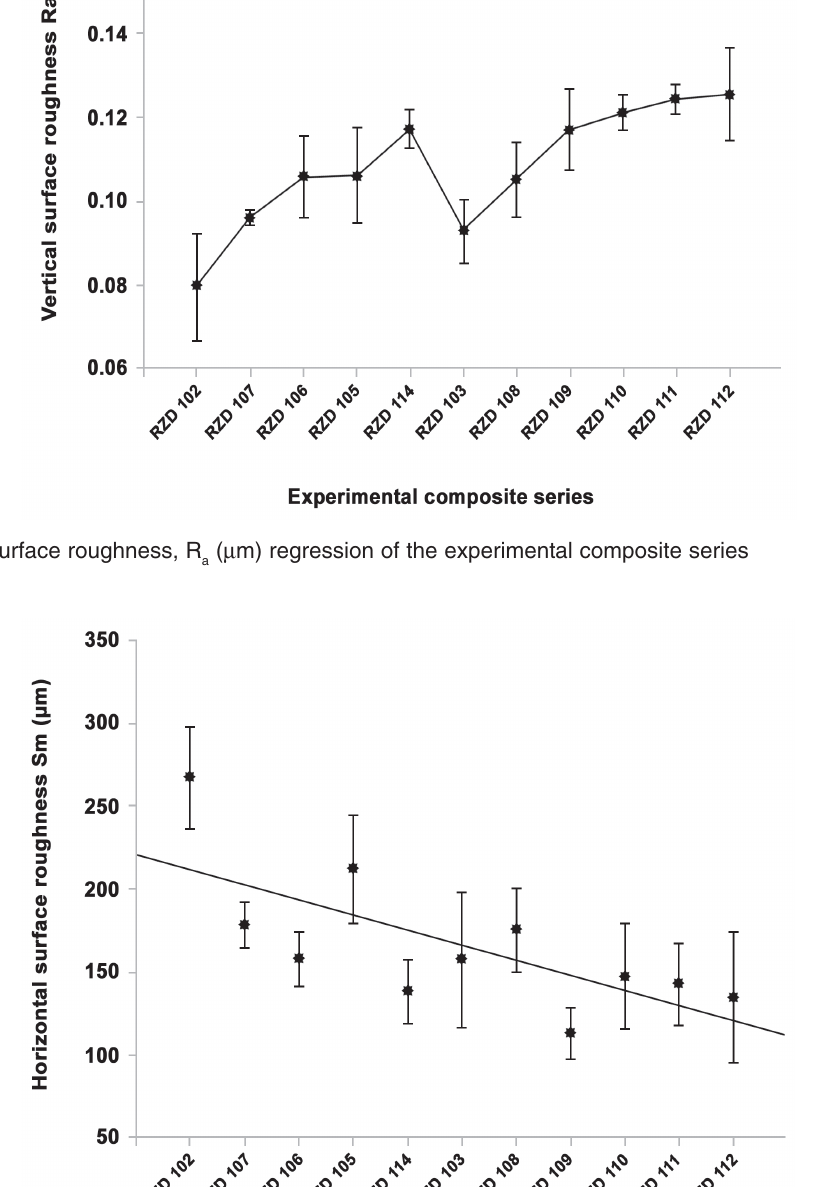
Figure 5- Horizontal surface roughness, Sm ( µ m) regression of the experimental composite